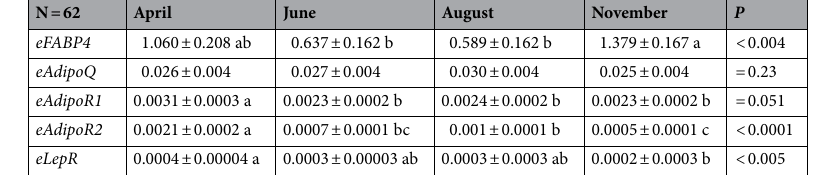
Table 6. Seasonal variations in mRNA expression levels*. eFABP4: emu Fatty Acid Binding Protein ; eAdipoQ: emu Adiponectin ; eAdipoR1: emu Adiponectin Receptor1 ; eAdipoR2: emu Adiponectin Receptor2 ; eLepR: emu Leptin Receptor. For each gene, means followed by different letters are significantly different by Tukey’s HSD. *mRNA expression relative to the housekeeping gene eβ-actin.